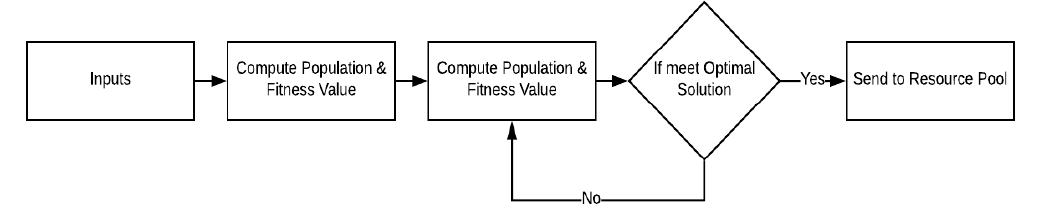
Figure 2. Flow of formal optimization model